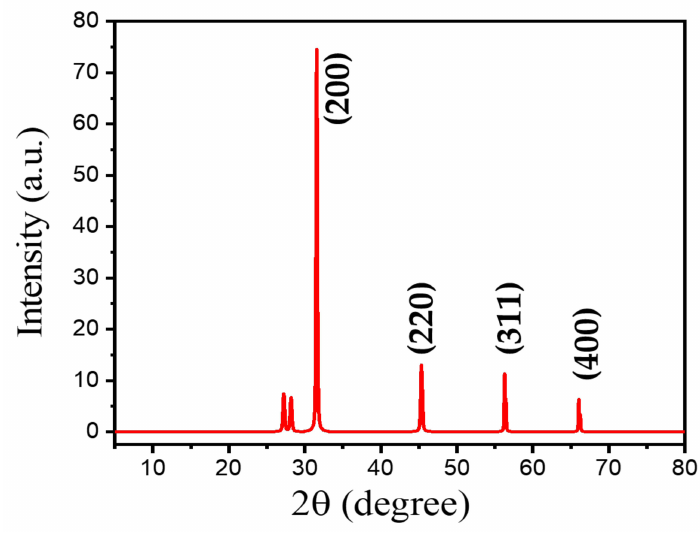
Figure 6. XRD pattern of biosynthesized Ag-based NPs using the waste of B. cereus culturing. Using the Scherrer equation, the crystallite size (CS) was determined from the XRD chart [29,30]. Williamson and Smallman’s relation, δ = 1 , is used in order to compute the CS 2 minimum dislocation density ( δ ). Table 1 includes the computed values for the crystallite size (CS), d-spacing, dislocation density, and microstrain. This is in addition to the estimated values for FWHM and the relative intensity of the four highest peaks in the XRD chart. The (200) orientation has the largest reported value (2.837 Å) of d-spacing, while the (400) plane has the lowest reported value (1.415 Å). The value of the crystallite along the optimum orientation was discovered to be 64.6 nm (200). Dislocation density values ranged from 0.831 × 10 − 4 nm − 2 for (400) to 3.684 × 10 − 4 nm − 2 for (220). A high degree of crystallinity along the (200) plane is present in the produced nano-crystallites, according to the XRD investigation [31]. With regard to non-uniform lattice distortions, faulting, dislocations, antiphase domain boundaries, and grain surface relaxation, the greatest microstrain % recorded was at 0.21954% for the preferred orientation (200) [32]. Table 1. Values of FWHM, relative intensity, the crystallite size (CS), d-spacing, dislocation density, and